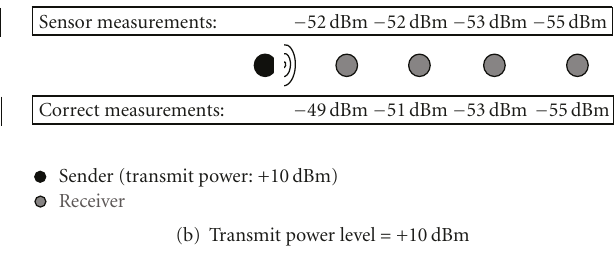
Figure 7: (a) Normal measurements. (b) The clipping e ff ect.